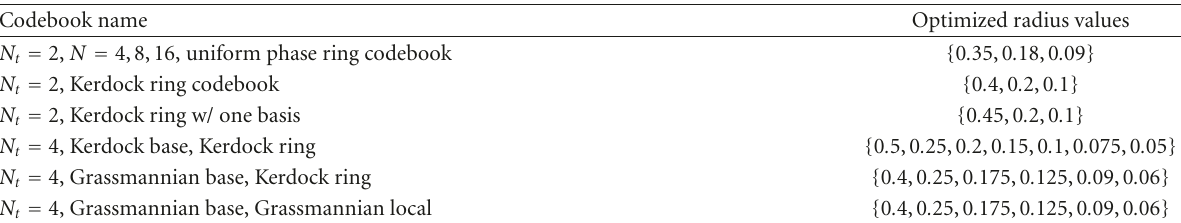
Table 1: Numerically optimized radius